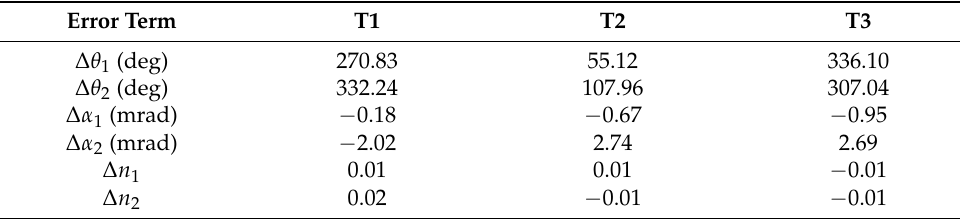
Table 1. Parameter errors for each sub-aperture.